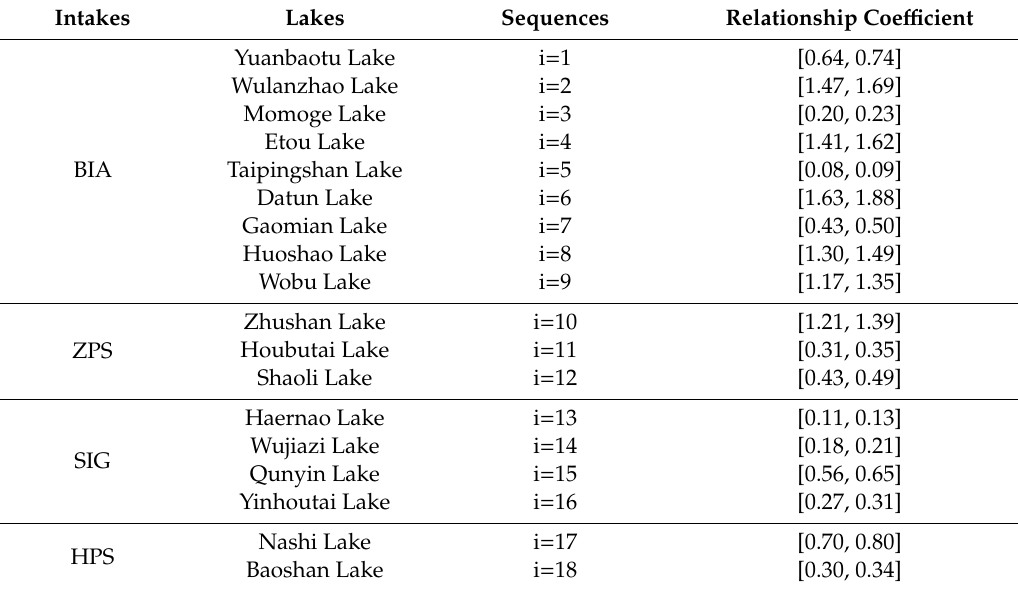
Table 4. Relationship coe ffi cient between the habitat area and water volume (in ha / 10 4 m 3 ).